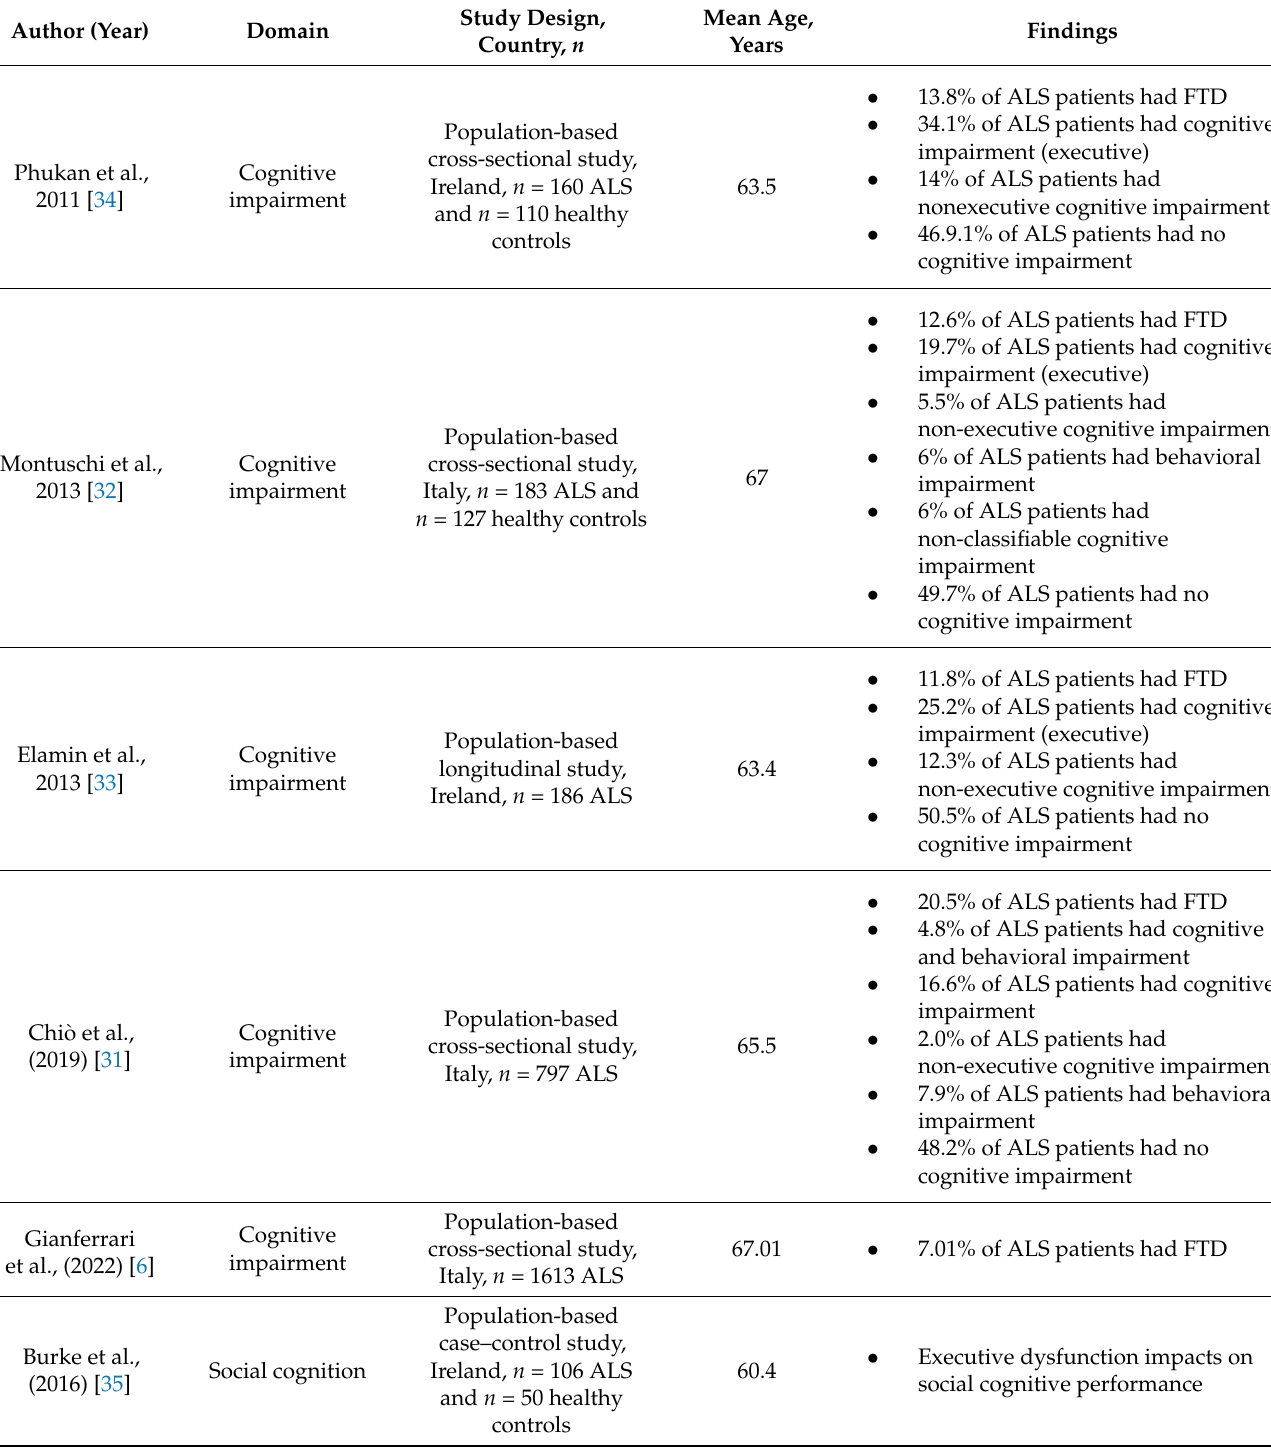
Table 3. Population-based studies of cognitive features in amyotrophic lateral